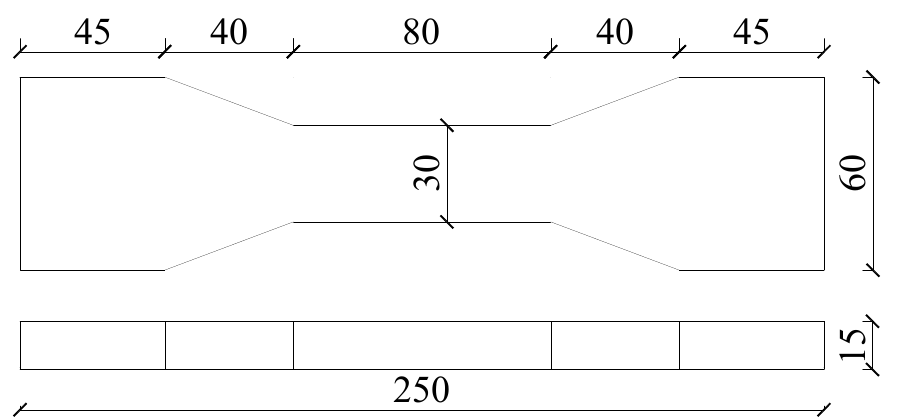
Figure 2. Dimensions of the dog bone specimen for the uniaxial tension tests.